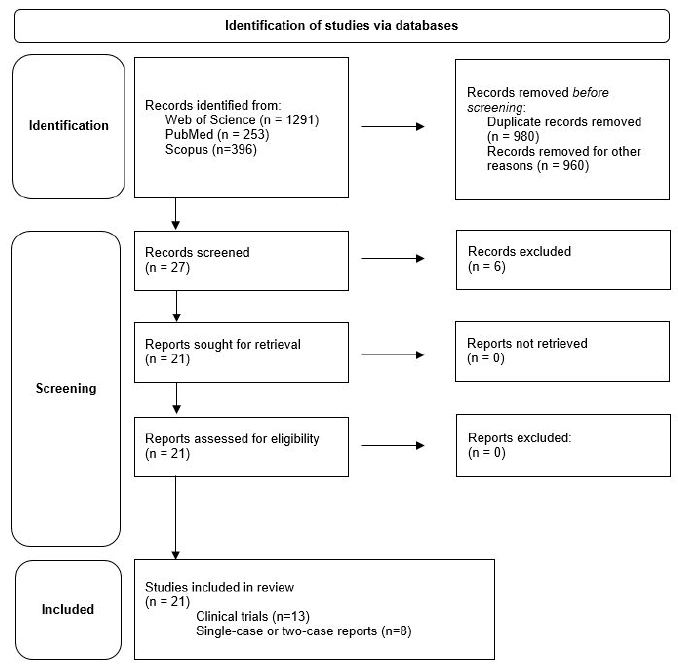
Figure 2. Presentation of the results of the literature search.